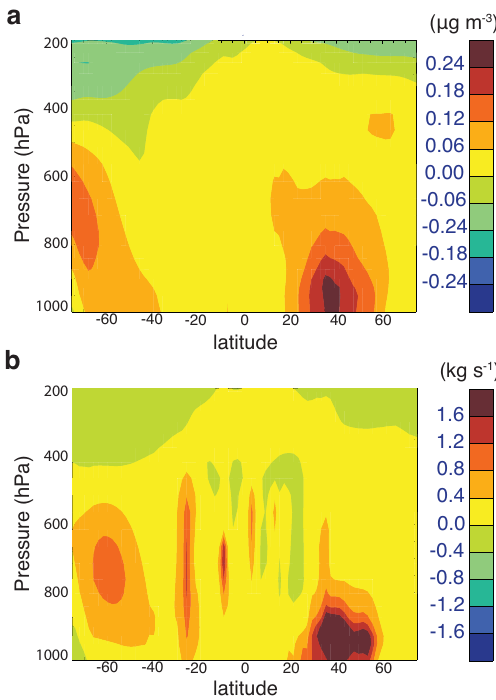
Fig. 3. Annual zonal mean differences in sulfate concentration (a) and gas-phase production (via OH) (b) , between WACFCs and